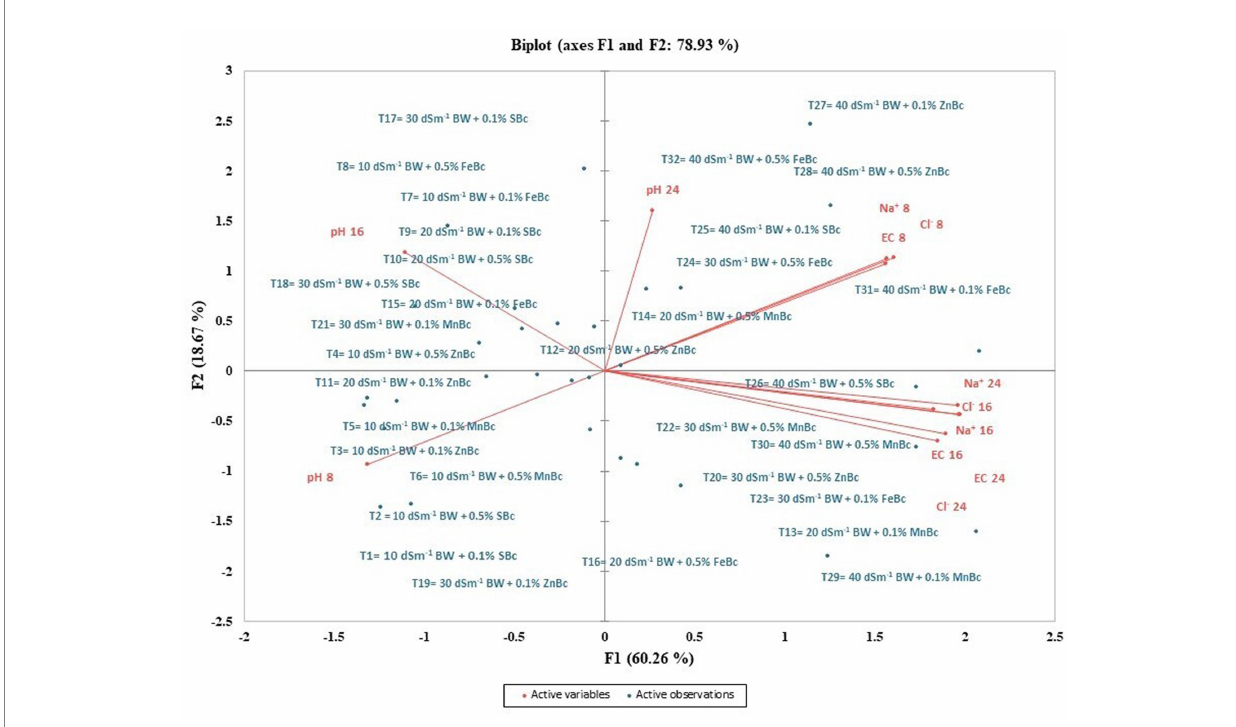
FIGURE 2 Principal component analysis (PCA) of different parameters of post-harvest soil of incubation study and F1 and F2 are PCA main factors which significantly participated to generate PCA biplot. However, active variables are Ph, EC and concentrations of Na + and Cl − ; while, active observations